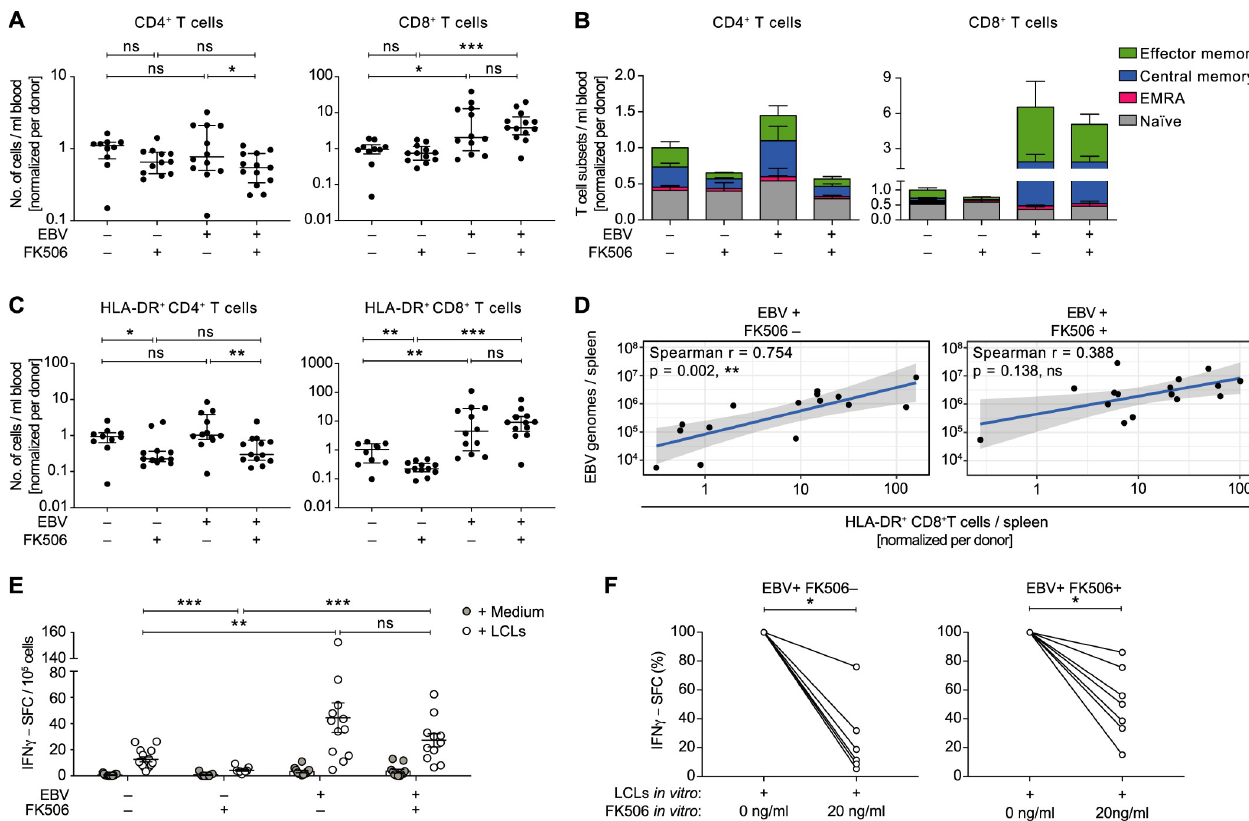
Fig 2. The EBV-induced T cell response is attenuated upon FK506 treatment. A) Total peripheral blood CD4 + or CD8 + T cell counts at the end of the experiment from individual mice (n = 10–13 animals per group) are shown relative to the mean of the EBV − FK506 – group of each HPC donor. Median (IQR), t test and MWT, respectively. B) Differentiation status of T cells in the blood at the day of sacrifice is represented as stacked bar graphs (n = 7–10 animals per group). Na ï ve: CD62L + CD45RA + , central memory: CD62L + CD45RA − , effector memory: CD62L − CD45RA − , effector memory RA + (EMRA): CD62L − CD45RA + . C) Relative numbers of activated CD4 + or CD8 + T cells in peripheral blood were determined by HLA-DR + surface staining and are depicted for individual mice (n = 10–14 animals per group). Median (IQR), MWT. D) Correlations between the splenic EBV DNA load and the relative number of splenic HLA-DR + CD8 + T cells are depicted for FK506-treated and non-treated EBV-infected mice. r, spearman correlation. Solid lines represent trend lines obtained by linear regression and shaded areas indicate 95% CI of each trend line. E) Number of EBV-reactive T cells was assessed for individual mice by Elispot assays whereby IFN γ spot-forming cells (SFC) were counted upon co-culture of CD19 MACS-depleted splenocytes or bone-marrow cells with autologous LCLs or medium. Mean ± SEM, MWT. F) Reduction in IFN γ –SFC (%) upon in vitro supplementation of 20ng/ml FK506 to CD19 MACS- depleted splenocytes during the co-culture with autologous LCLs. Depicted for EBV-infected mice with (n = 7) and without (n = 6) in vivo FK506-treatment. Wilcoxon matched-pairs test on raw IFN γ –SFC counts. Composite data from two ( B ), three ( A, C ) or four ( D, E ) independent experiments. See also S2 Fig. � : p < 0.05, �� : p < 0.01, ��� : p <